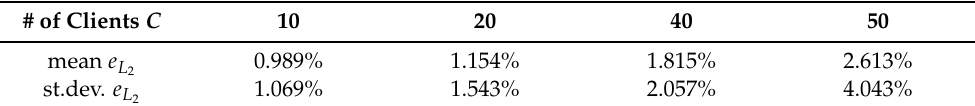
Table 1. The mean and standard deviation of the L 2 -relative errors computed when predicting with Random Field and a variable number of clients within the set C ∈ { 10,20,40,50 } .